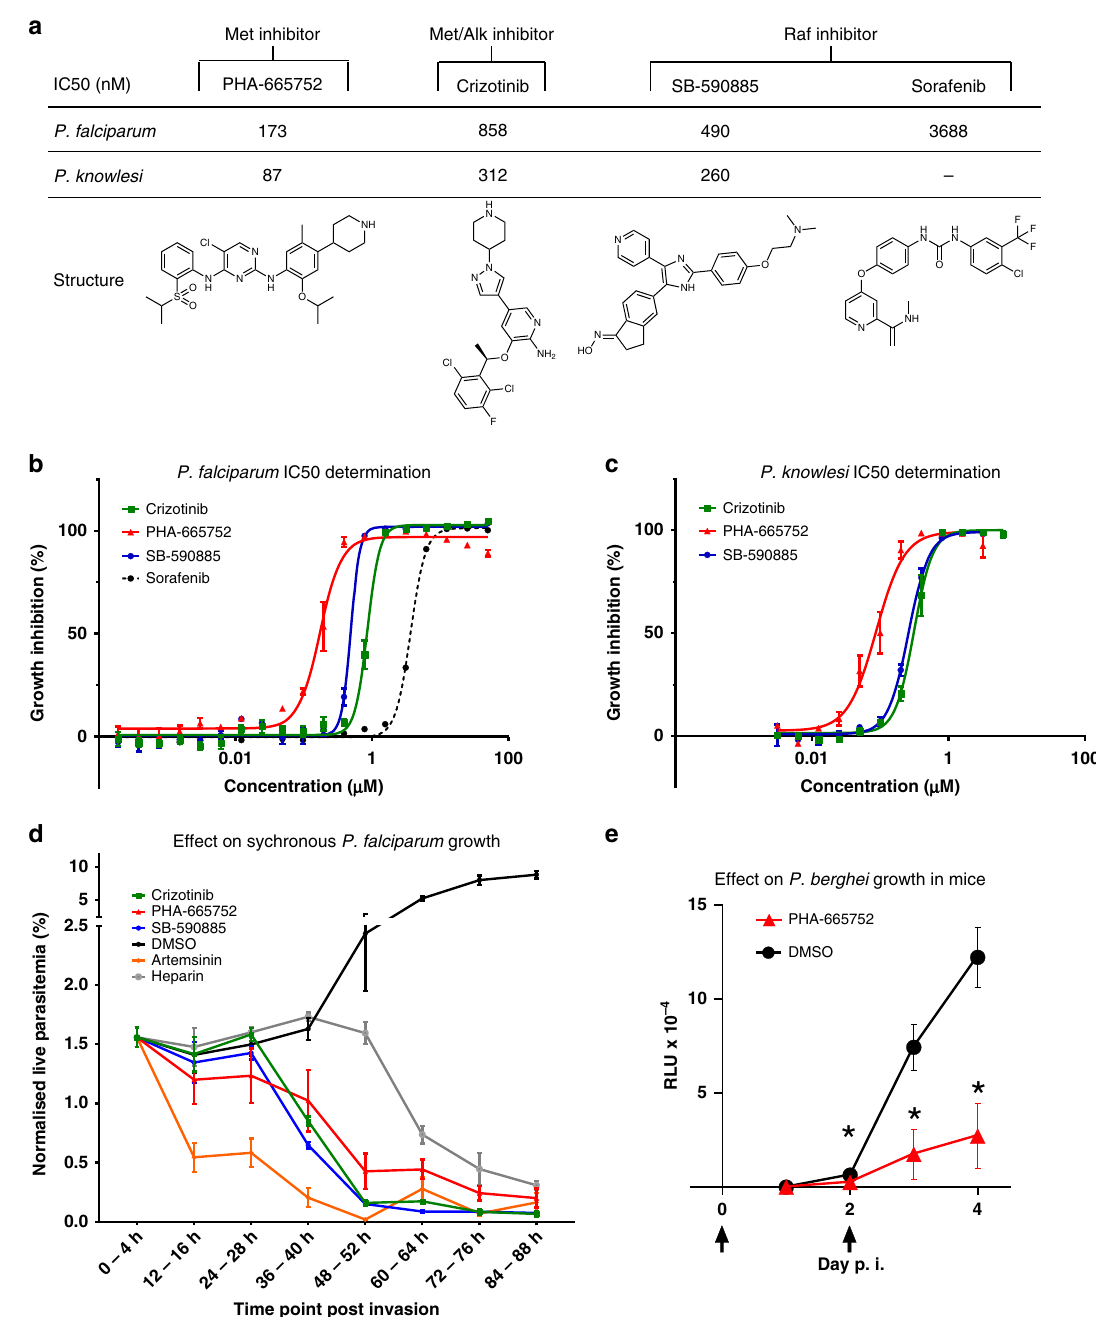
Fig. 6 IC 50 and phenotypic effect of human kinase inhibitors on Plasmodium blood-stage development. a IC 50 values of the human kinase inhibitors Crizotinib (MET/ALK inhibitor), PHA-665752 (Met inhibitor), SB-590885 (B-Raf inhibitor) and Sorafenib (B-Raf inhibitor, P. falciparum only) on asynchronous P. falciparum and ring-stage P. knowlesi asexual growth. b Growth inhibition curve for asynchronous P. falciparum , IC 50 measured after 72 h of compound exposure, n = 3, n = 2 for sorafenib ( n represents biologically independent samples), data are presented as mean values ± SEM. c Growth inhibition curve for P. knowlesi , IC 50 s measured after 50 h of compound exposure, n = 3 biologically independent samples, data are presented as mean values ± SEM. d Effect of treatment with 5× the IC 50 value of the compounds Crizotinib, PHA-665752, SB-590885, Artemisinin, DMSO (equivalent volume of DMSO in Crizotinib sample) and heparin (15 μ l/ml) on highly synchronous (4 h window) P. falciparum cultures over 88 h ( n = 5 biologically independent samples). The Y -axis represents the live parasitemia values for each time point normalized to a starting total parasitemia of 2%, data are presented as mean values± SEM. e Effect of treating mice with PHA-665752 on the growth of P. berghei . The graph shows relative luminescence units (RLU) in the blood of BALB/c mice infected with parasites constitutively expressing fi re fl y luciferase and treated or not with PHA-665752 at 25 mg/kg at times indicated by arrows. * p < 0.01 by two-tailed T -test; n = 7 mice per treatment group, data are presented as mean values± SEM. Source data are provided as a Source Data fi